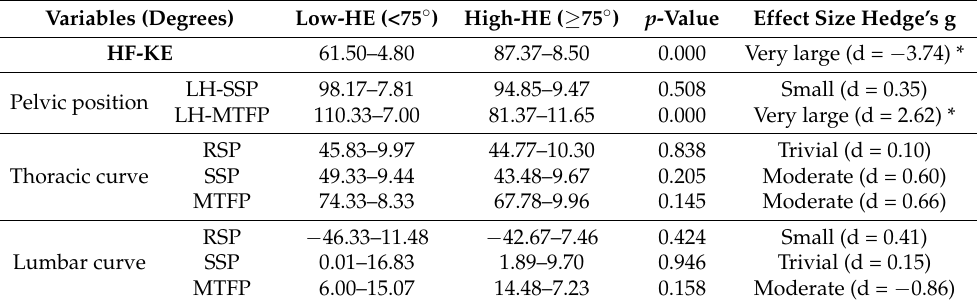
Table 3. Comparative analysis between low ( n = 8) and high ( n = 27) hamstring extensibility groups on sagittal pelvis position and spinal curve in female soccer and basketball players.